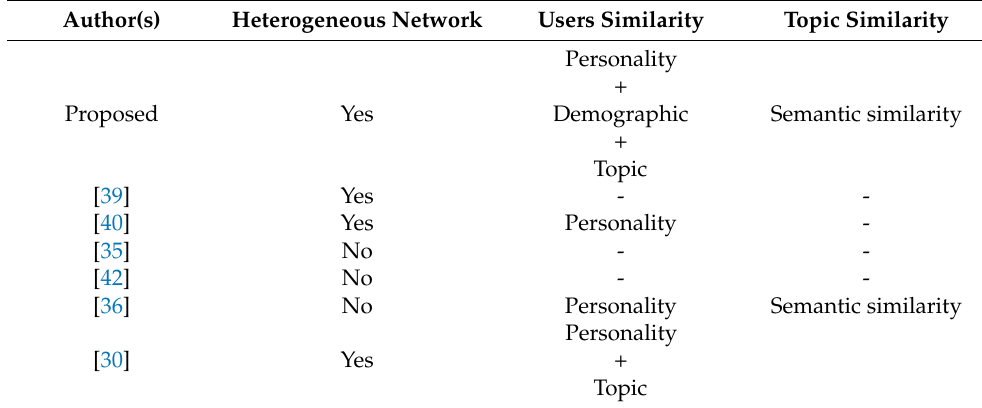
Table 12. Compared to previous research. Heterogeneous